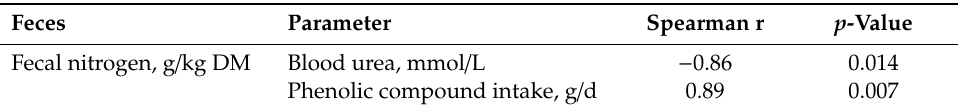
Table 6. Correlation (Spearman correlation) among feed, feces ( n = 6 / treatment) and blood parameters ( n = 6 / treatment) on day 40 1,2 of the in vivo trial (from 35- to 75-day-old